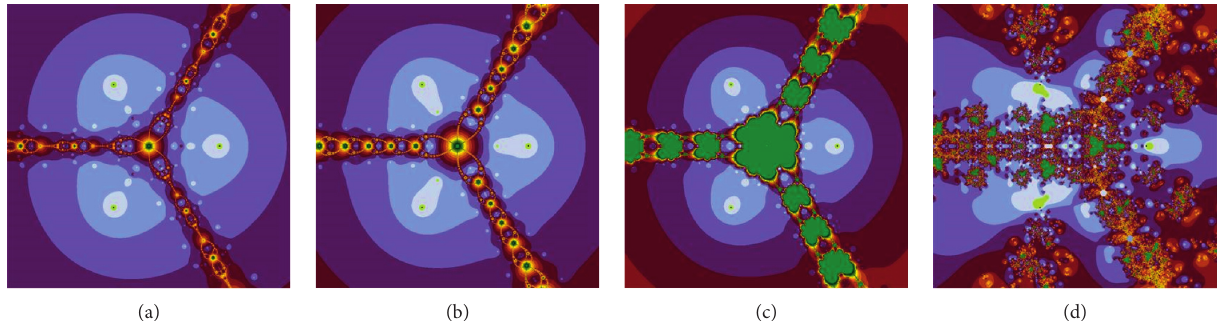
Figure 3: Polynomiographs related to the complex polynomial q (d) Algorithm 1.